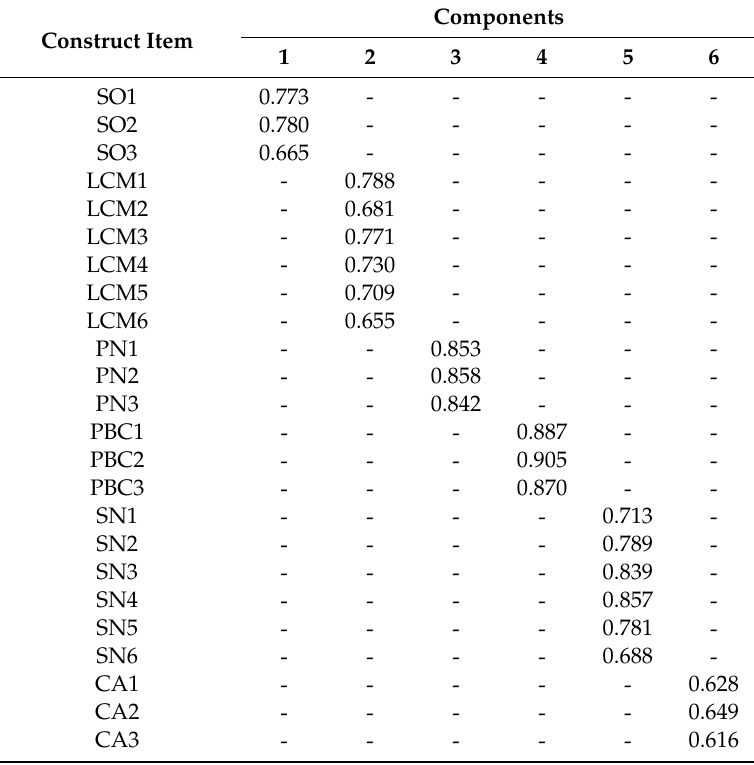
Table 7. Rotated component